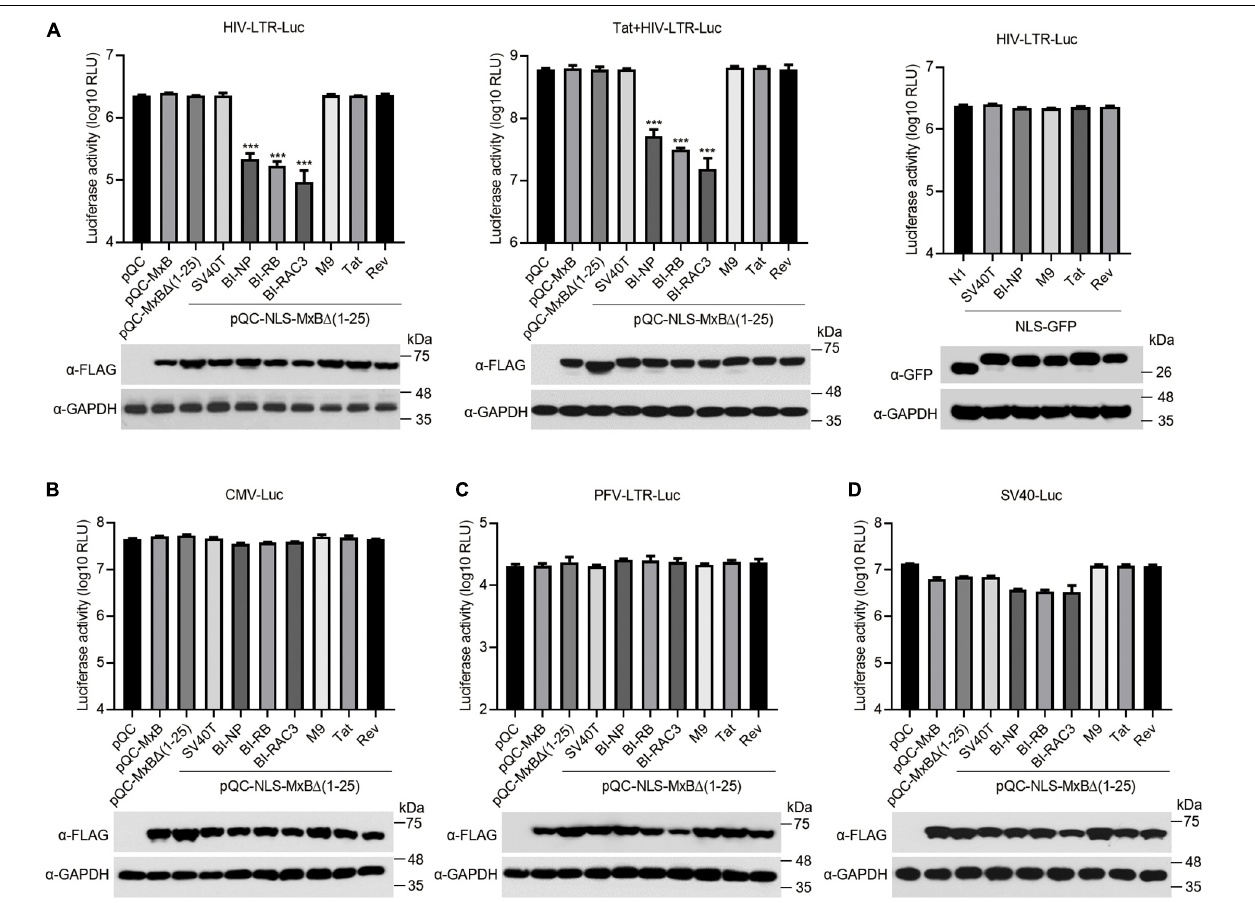
FIGURE 4 | The bipartite NLS-bearing MxB suppresses HIV-1 LTR promoter activity. (A) HEK293T cells were co-transfected with HIV-LTR-Luc DNA containing a luciferase reporter gene driven by the HIV-LTR promoter, together with MxB or its mutant DNA (left panel). Same transfections were performed by including HIV-1 Tat DNA (middle panel). HIV-LTR-Luc DNA was also co-transfected with GFP DNA bearing different types of NLS (right panel). At 48 h post-transfection, the transfected cells were collected to measure luciferase activity which is presented in log10 RLU (relative light unit). Expression of MxB or NLS-GFP was examined by